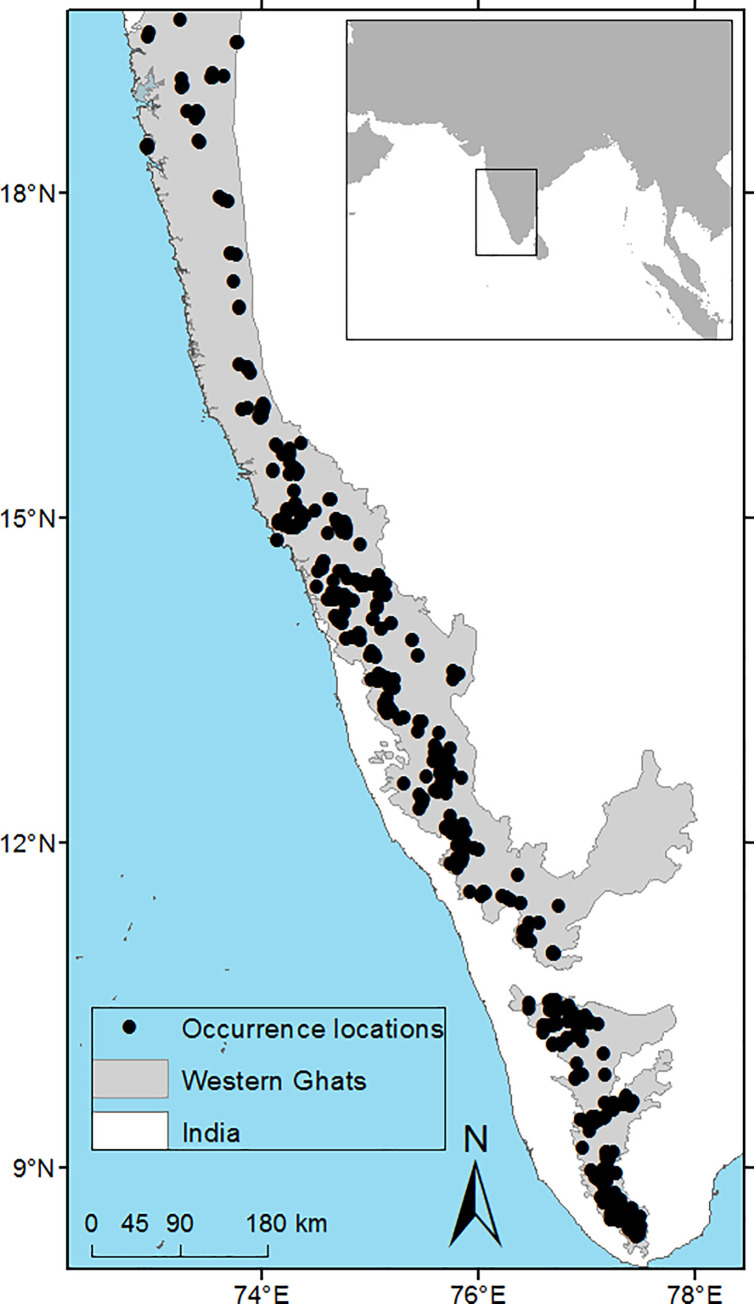
Extent of the study area and spatial distribution of species occurrence.Species occurrences represent primary plot-based sampling (S1 Table) and secondary data based on published species inventories (S2 Appendix).